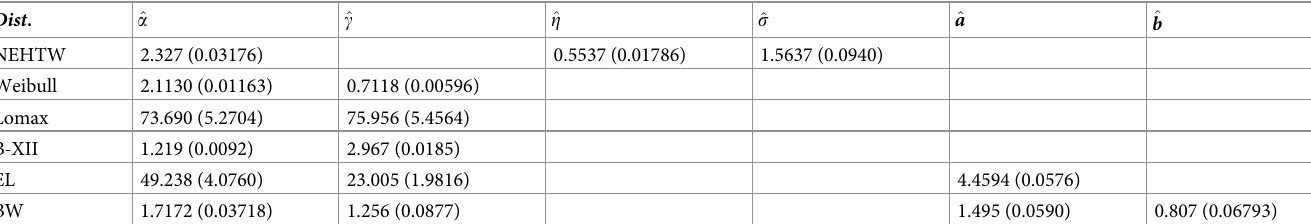
Table 9. Parameters estimates and standard errors (in parentheses) of the NEHTW model with other models. Dist .